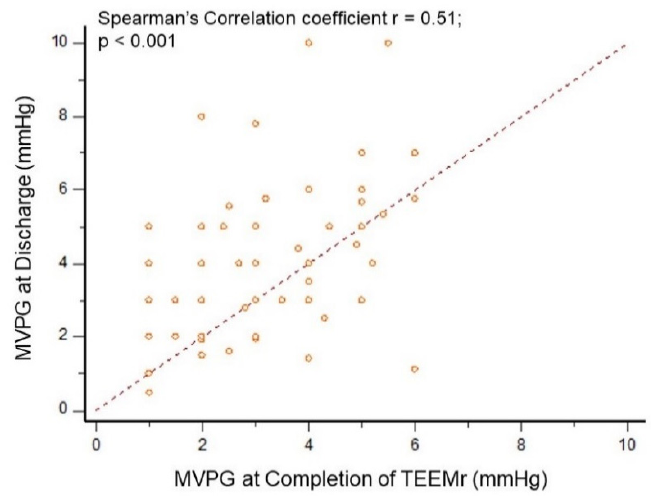
Figure 4. MVPG Correlation analysis at completion of TEEMr and at discharge. Scatter plots for Spearman’s correlation analysis between MVPG assessed by TEE at completion of TEEMr and MVPG assessed by TTE at discharge. Filled circles represent individual measurements. MVPG, Mitral valve pressure gradient; TEE, transesophageal echocardiography; TEEMr, Transcatheter edge-to-edge mitral valve repair; TTE, Transthoracic echocardiography.